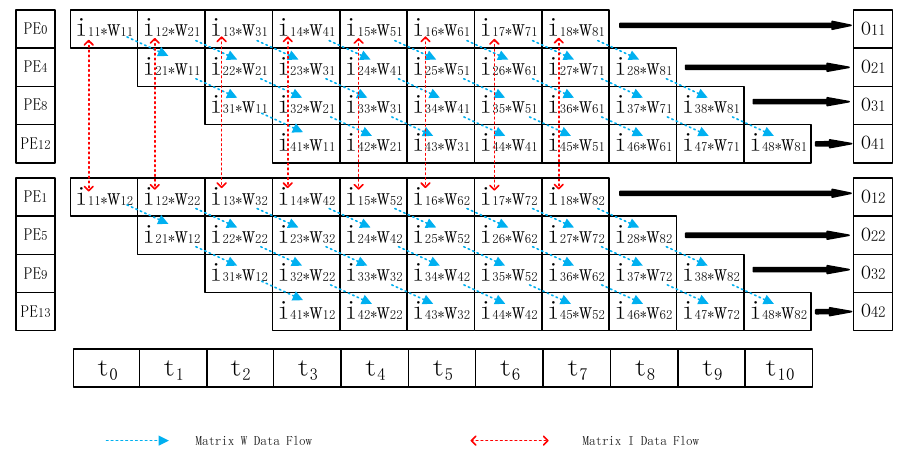
Figure 10. The working flowchart of MMA.